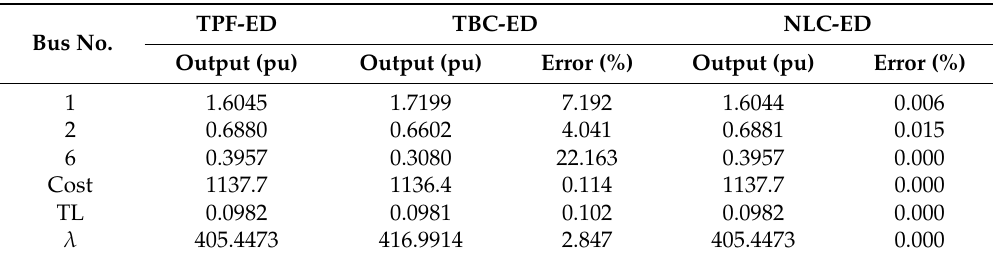
Table 3. ED simulation results compared with traditional ED and new loss coefficients of IEEE 14-bus system under the base case system demand